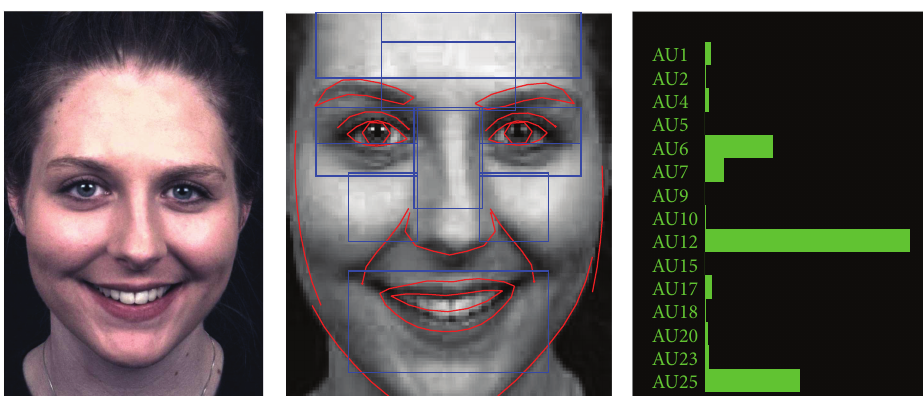
Figure 1: Automated Action Unit recognition system. For each frame of a video, geometric changes in facial components (red curves) are automaticallytracked,andtexturalchangesduetotemporarywrinklesaredetectedinmultipleregionsofinterest(blueboxes).Theseextracted features are fed through pattern classifiers to yield activity of each Action Unit (green bars: longer bar means higher